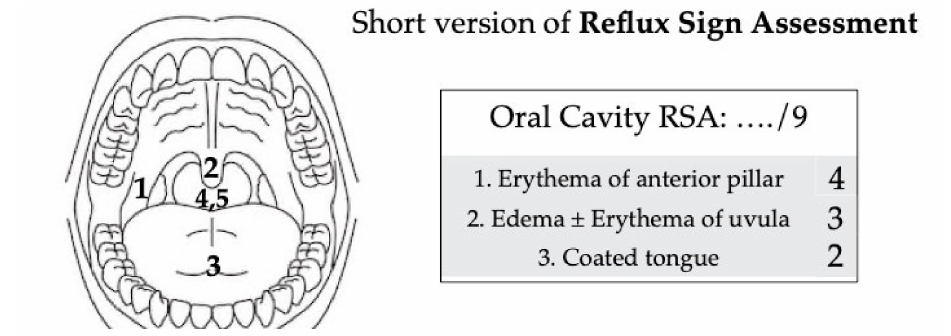
Figure 1. Reflux Symptom Score. The questionnaire is subdivided into three parts according to the complaints: ear, nose, and throat (part 1, 9 items); digestive (part 2, 9 items); and respiratory (part 3, 4 items) symptoms. The frequency and severity of each symptom are rated with a 5-point scale. For each item, the severity score is multiplied by the frequency score to obtain a symptom score ranging from 0 to 25. The sum of these symptom scores is calculated to obtain the RSS final score (ranging from 0 to